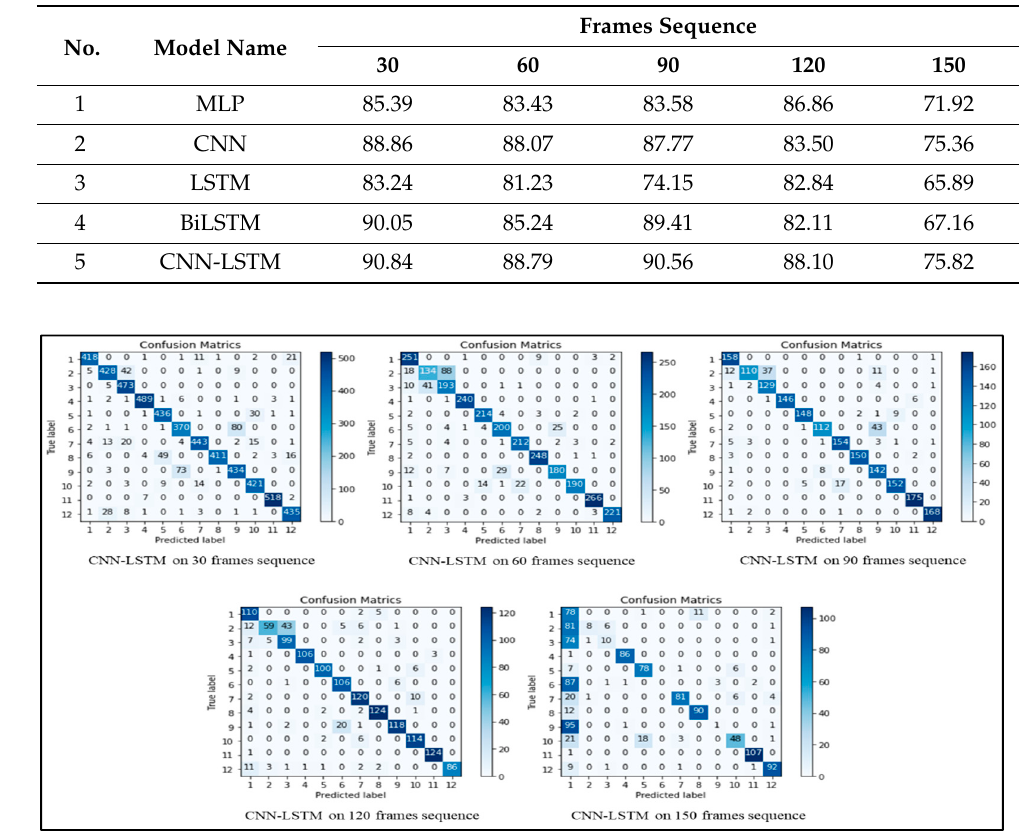
Figure 8. Comparison graph of the proposed model with other DL models. 5. Conclusions Human activity recognition through visual sensor data is a very challenging area of research from the past decades. In this paper, we propose a hybrid approach that com- bines CNN and LSTM to effectively recognize human activity with higher accuracy. The main purpose of using this hybrid approach in activity recognition is that human activity is actually the sequence of action that contains temporal information. CNN architecture has the advantage of extracting the discriminative features while LSTM can extracts the temporal information in time-series data. We used our own dataset which is collected from 20 participants where each participant performs 12 physical activities. This dataset contains different physical activities which can improve the individual’s health. We con- ducted extensive experiments on both machine learning classifier and deep learning mod- els. We performed experiments on various machine learning classifiers such as SVM, KNN, Decision Tree, Naïve Bayes, Linear Discriminant, Ensemble classifiers (Boosted